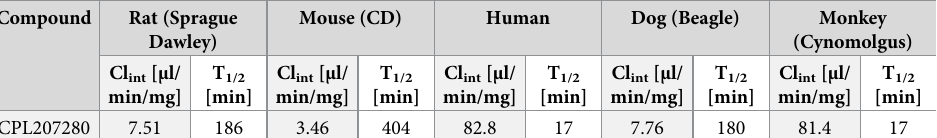
Table 3. Stability of CPL207280 and TAK-875 in the presence of hepatocytes from different species.